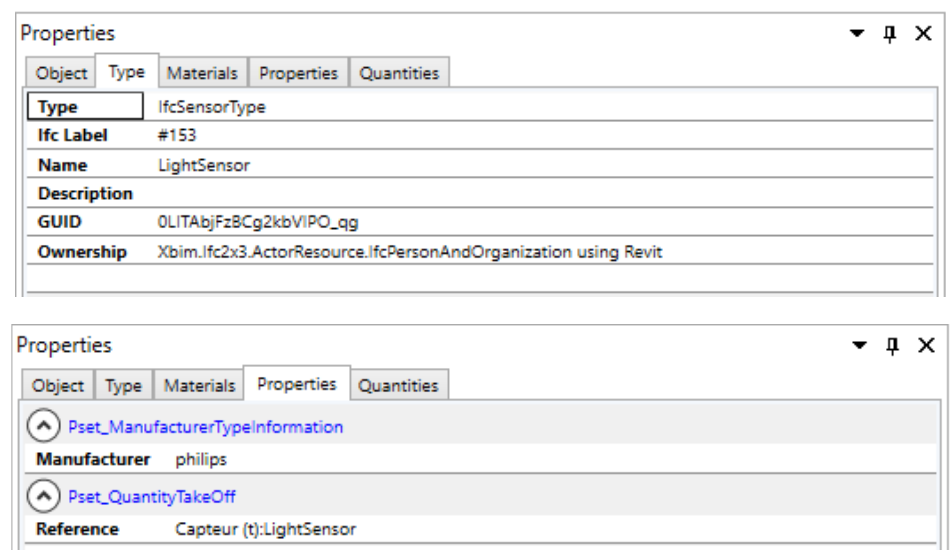
Figure 6. Representation and export of semantic data to XbimXplorer in IfcBuildingElementProxy (first prototype), and using the family and type for reference (second prototype).